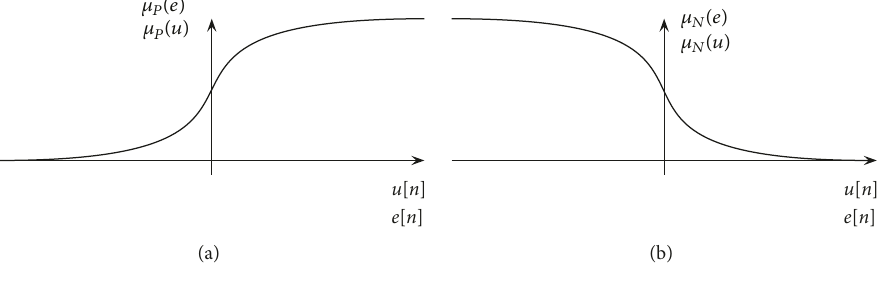
Figure 12: Membership functions